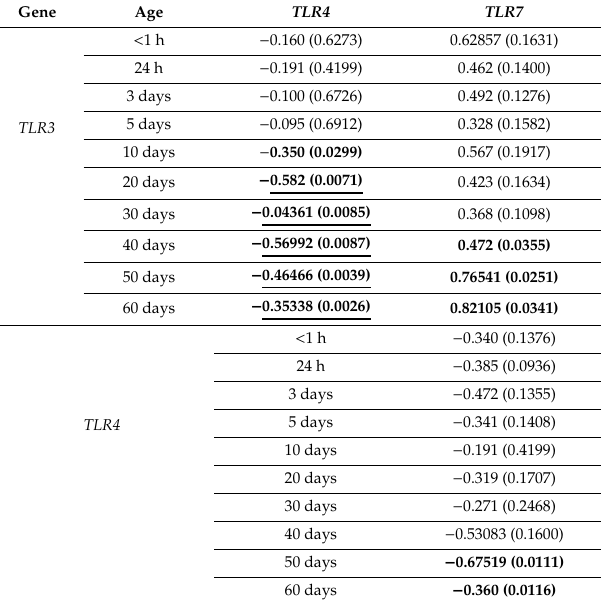
Table 4. Correlations ( p -value) of the expression of TLR3 , TLR4, and TLR7 mRNA over the subsequent days of age of the foals from the control group.